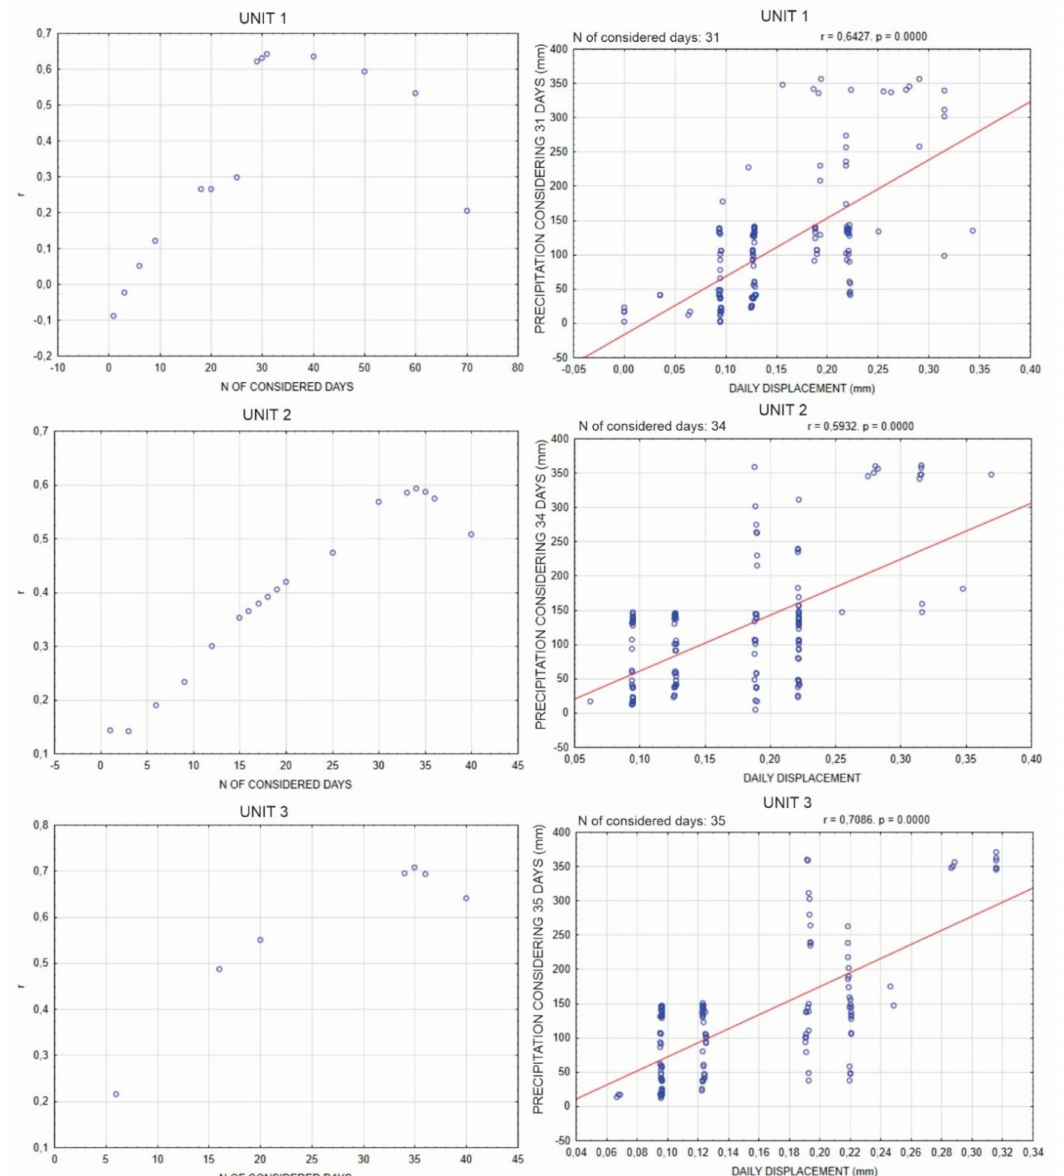
Figure 16. Determination of the highest correlation (r) between daily displacement and the number of days considered for antecedent precipitation (left), and correlation between daily displacement and established best-correlated number of antecedent precipitations for units